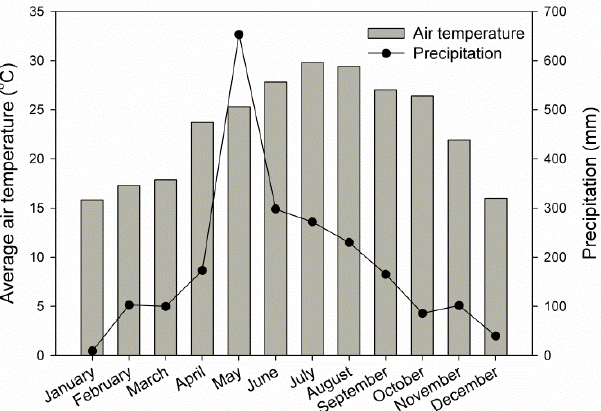
Figure 1. Monthly average air temperature and the amount of precipitation in the investigation year